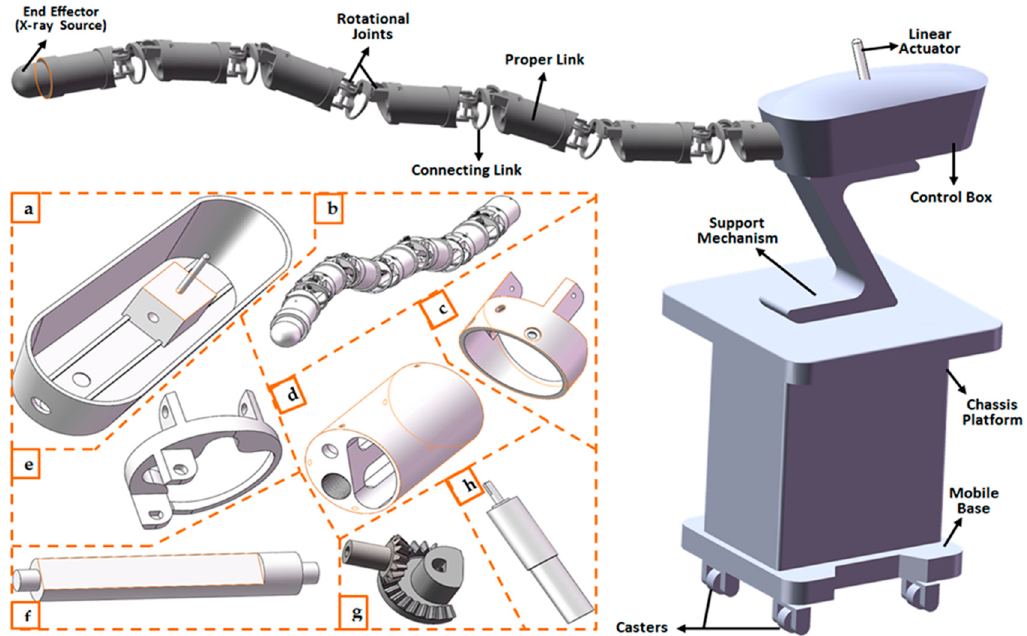
Figure 1. Design of the flexible snake-like robot: ( a ) translational joint mechanism, ( b ) flexible links with rotational joints, ( c ) end caps, ( d ) proper link, ( e ) connecting link, ( f ) inter-module and intra-module link connectors, ( g ) rotational joint mechanism, and ( h ) linear actuator.